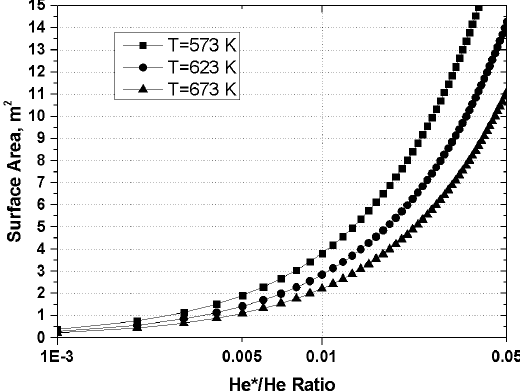
Figure 3. Membrane surface area vs. the lumen pressure at different temperatures with a shell (permeate) pressure of 5 kPa.